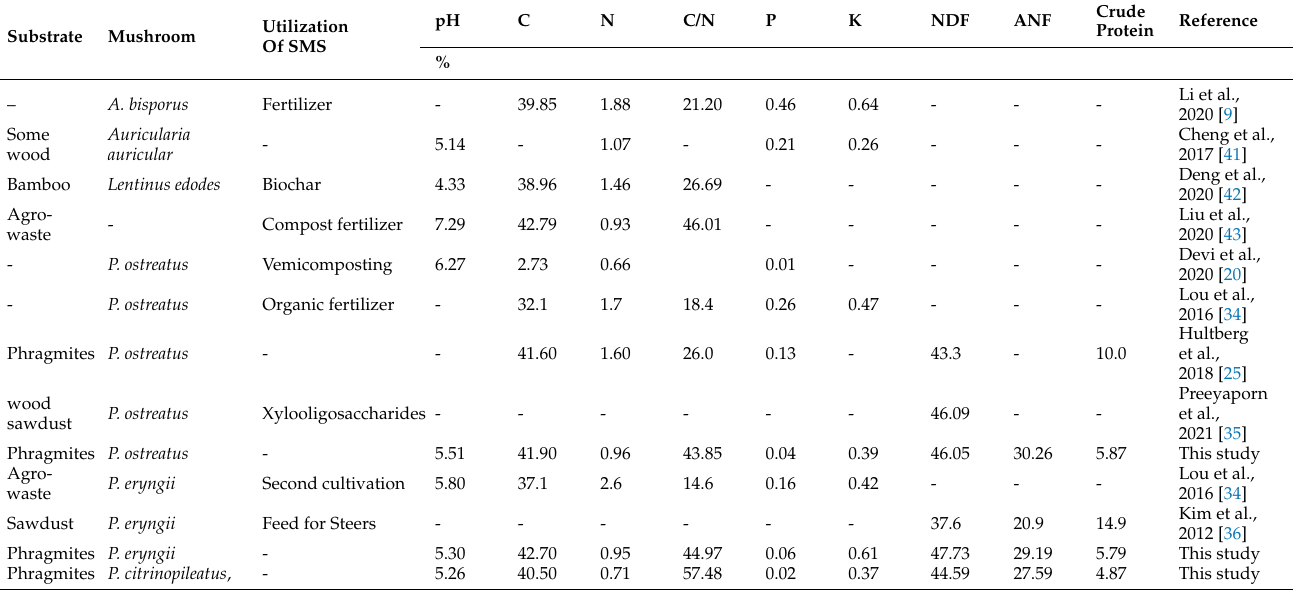
Table 4. Comparison of SMS with other